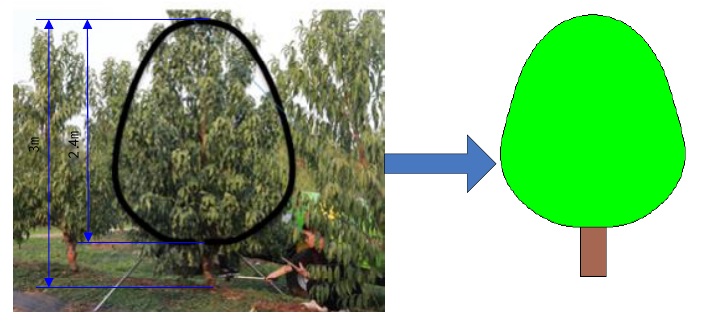
Figure 2. Simplified tree crown model.